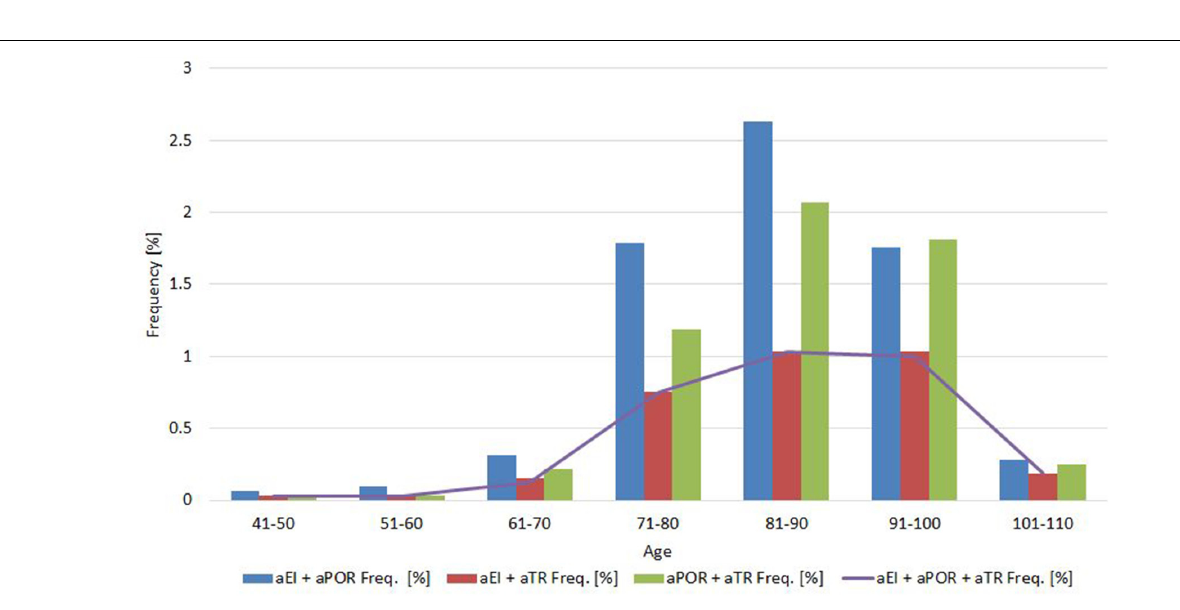
FIGURE 3 | Proportion of abnormal values for pairs of (and all) neuroimaging measures in 10-year age